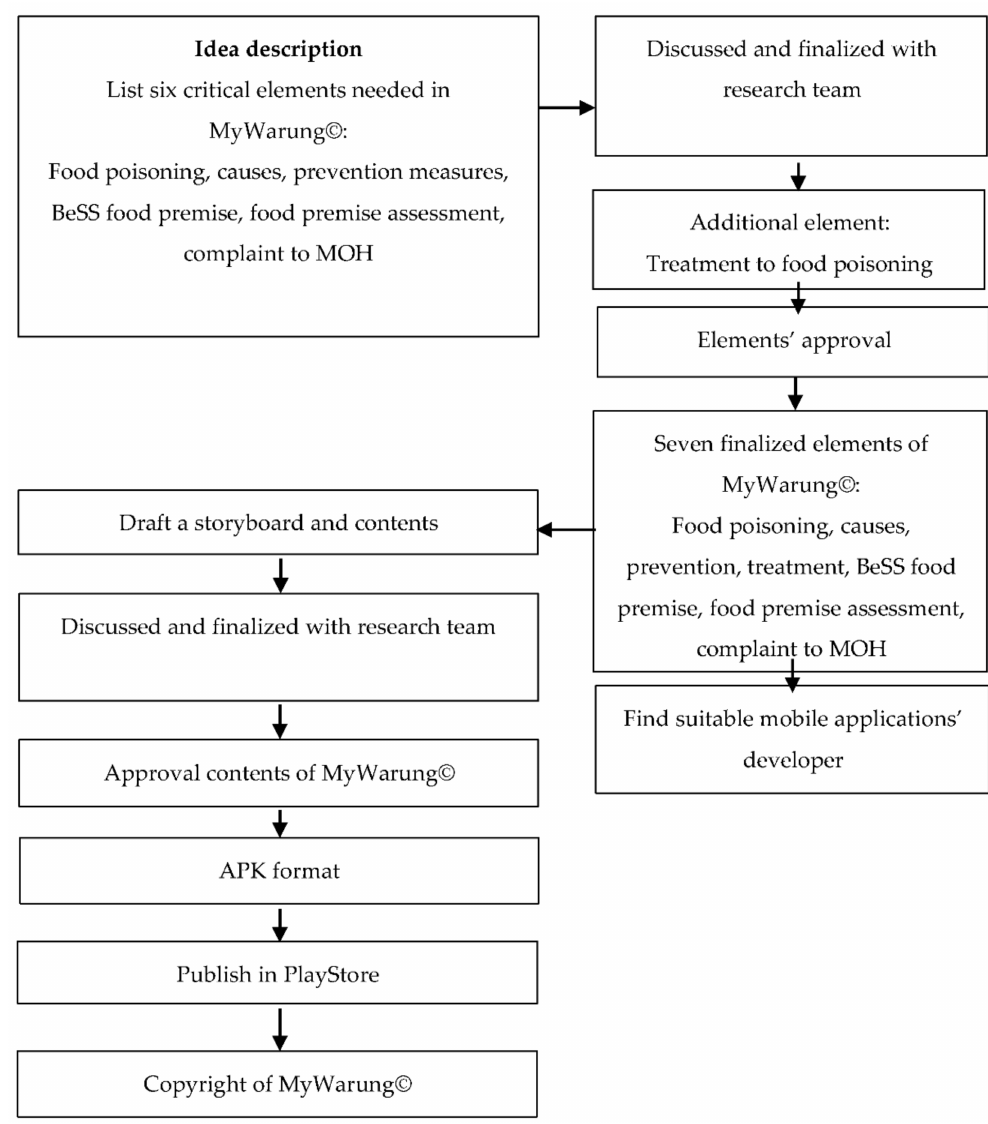
Figure 2. Development process of